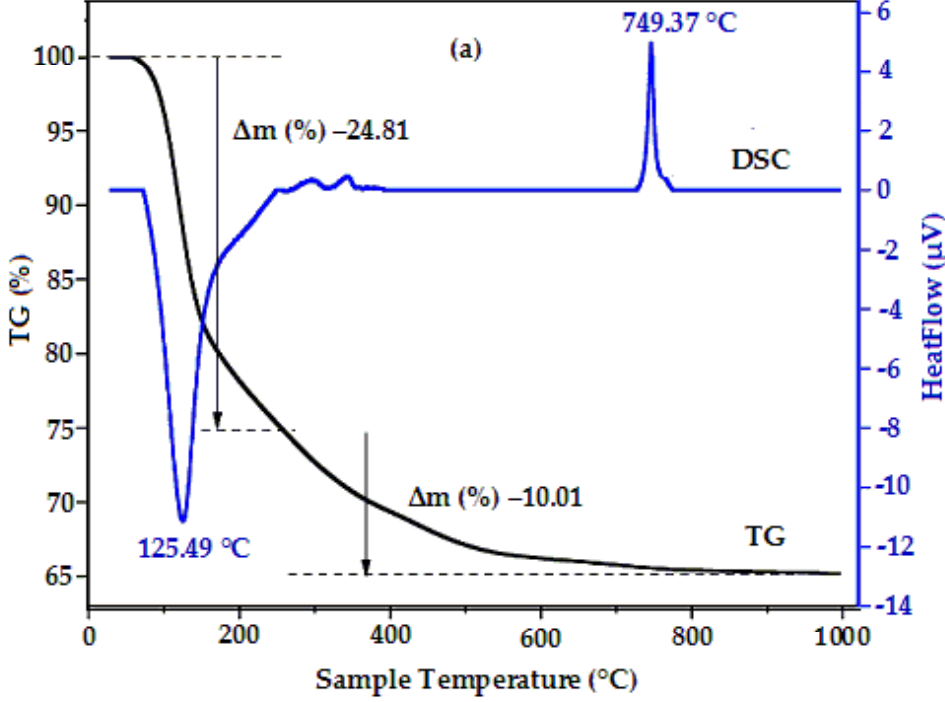
Figure 1. Combined TGA-DSC plots of HoFeO 3 precipitate sample The endothermic and exothermic peaks specifically appear on the DSC curve at 125.49 and 749.37 °C, respectively. Herein, the weight loss after annealing is attributed to the water removal from the surface, resulting from the crystallization and dehydration of Fe 2 O 3 .xH 2 O (x = 1–5) [21] and HoO(OH).yH 2 O [22]. Hence, the temperatures of 650, 750, 850 and 950 °C, were chosen for investigating structure and morphology of HoFeO 3 na- noparticles. Figure 2a shows the XRD pattern of HoFeO 3 after annealing at 650, 750, 850 và 950 °C for 1 h. As a result, HoFeO 3 reveals an amorphous state at 650 °C. Whereas, at the different annealing temperatures, the samples are in good accordance with the standard JCPDS: 46-0115 of the orthorhombic HoFeO 3 single-phase, which are correspondent to the exothermic peak on the DSC curve (749.37 °C). Furthermore, the SEM and TEM images of HoFeO 3 nanoparticles annealed at 750 °C are shown in Figure 2b,c. Herein, the orthoferrite HoFeO 3 particles are discrete with an average size of 10–20 nm, which are smaller and without conglomeration of particles com- paring to HoFeO 3 nanoparticles prepared by hydrothermal [12], sol-gel [13–15], and co- precipitation using ethanol [17]. Figure 3a shows the EDAX spectra of HoFeO 3 , in which presence of Ho and Fe ions are clearly seen. An analysis of the weight and atomic percent of HoFeO 3 nanoparticles is in agreement with the theoretical value calculated from the chemical formula.